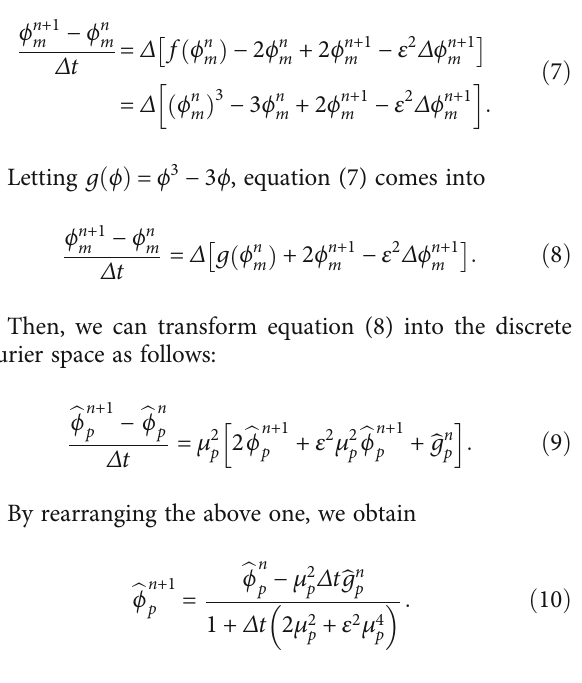
Figure 1: Schematic illustration of double-well potential F ð ϕ Þ , F ′ ð ϕ Þ , and F ′′ ð ϕ Þ